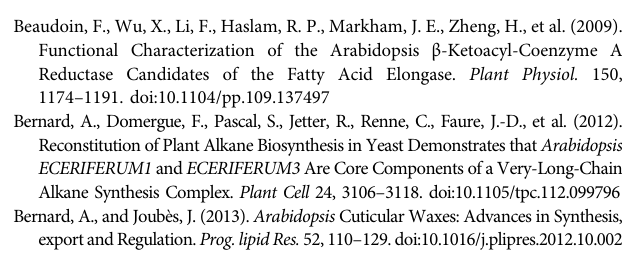
Supplementary Table S5 | Promoter sequence and classi fi cation